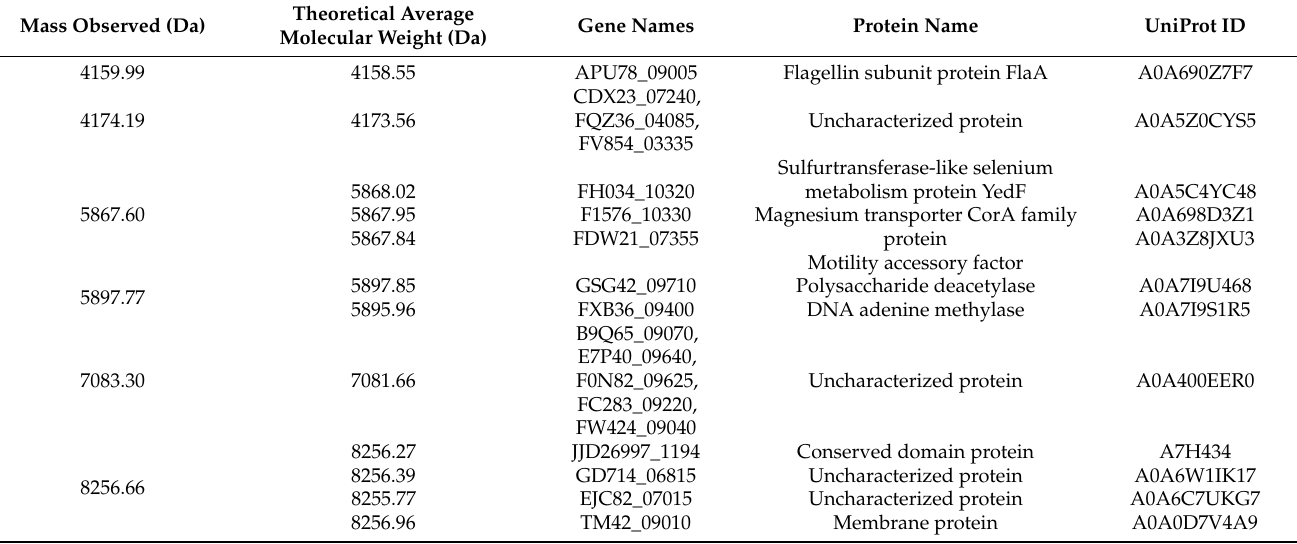
Figure 4. Biomarker mass peak of C. jejuni identified by machine learning decision tree algorithm. X -axes: mass-to-charge ratio (m/z). Y -axes: intensity in arbitrary unit. Table 3. Putative biomarkers linked to the Campylobacter type and their identification through the Uniprot database. Mass Observed